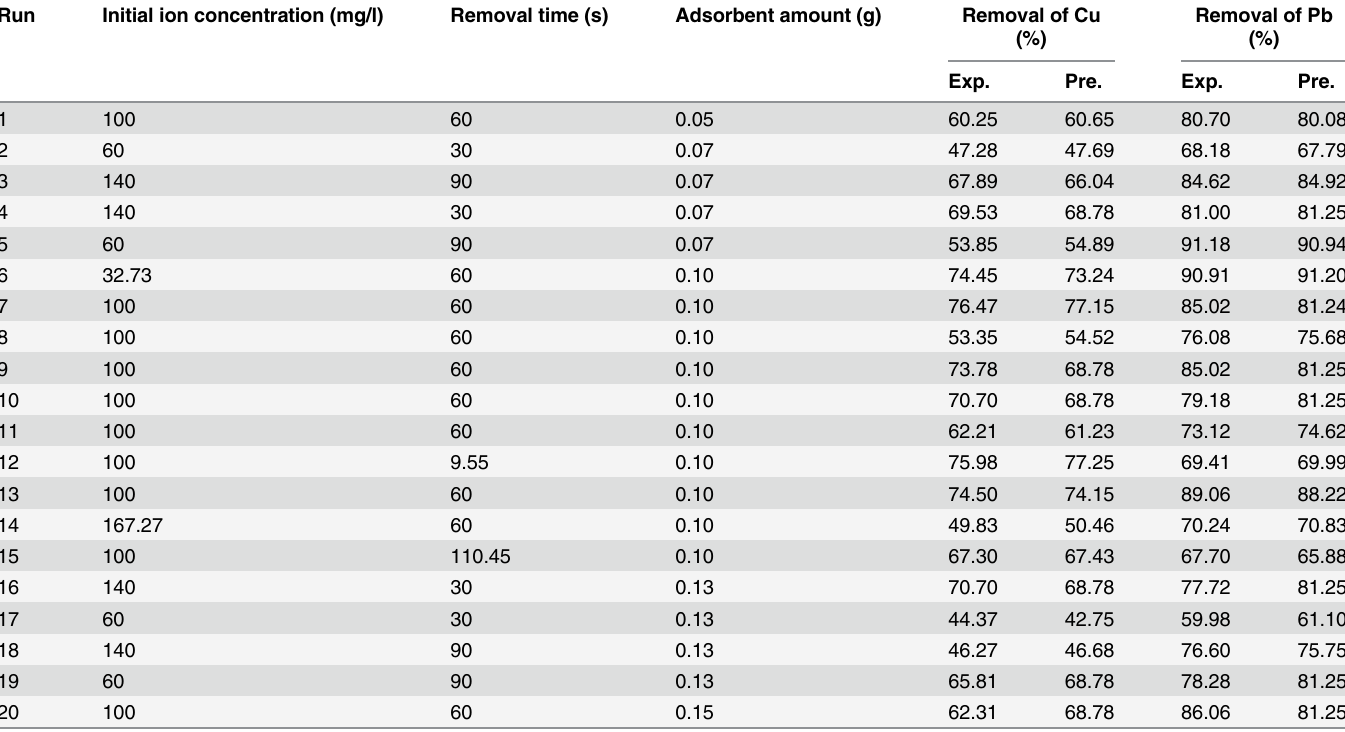
Table 2. Predicted and experimental values of removal of Cu(II) and Pb(II), based on central composite rotatable design (CCRD). Run Initial ion concentration (mg/l) Removal time (s) Adsorbent amount